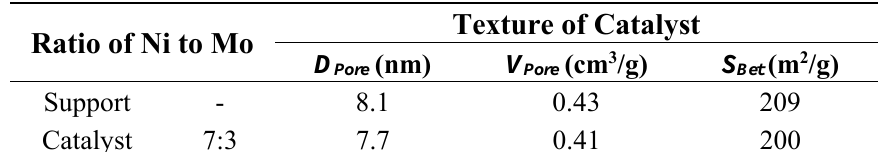
Table 5. Texture of